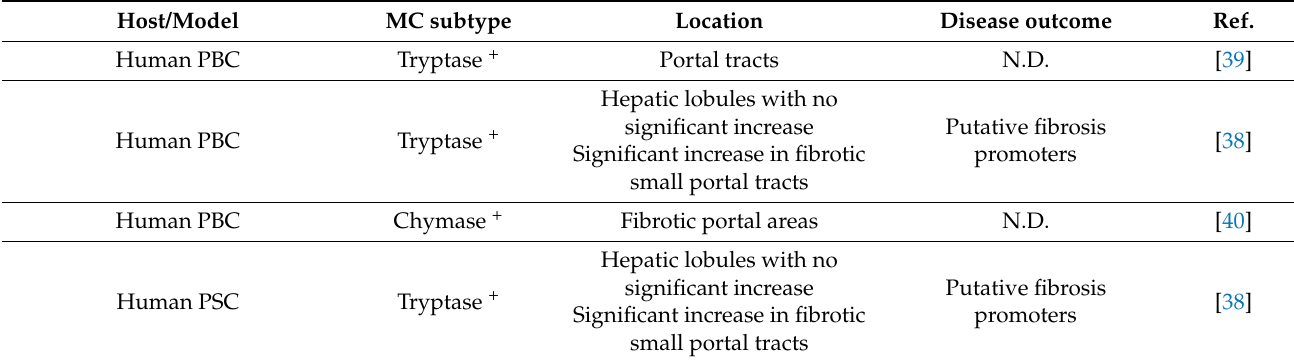
Table 1. Relevance of MCs in human and mouse immune